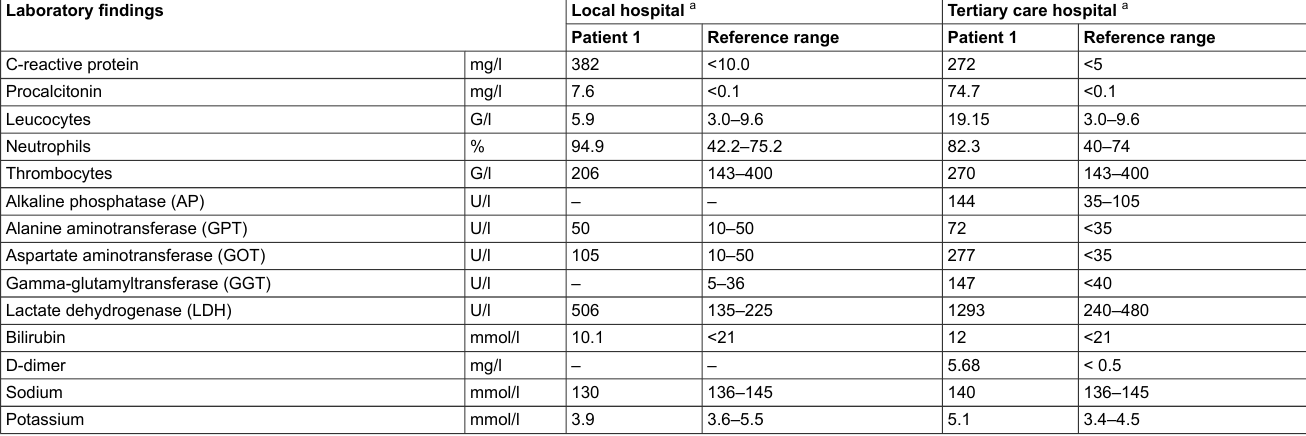
Table 1: Patient 1: Blood chemistry results at the local and tertiary care hospital (final diagnosis: pneumonia due to Chlamydia psittaci). Laboratory